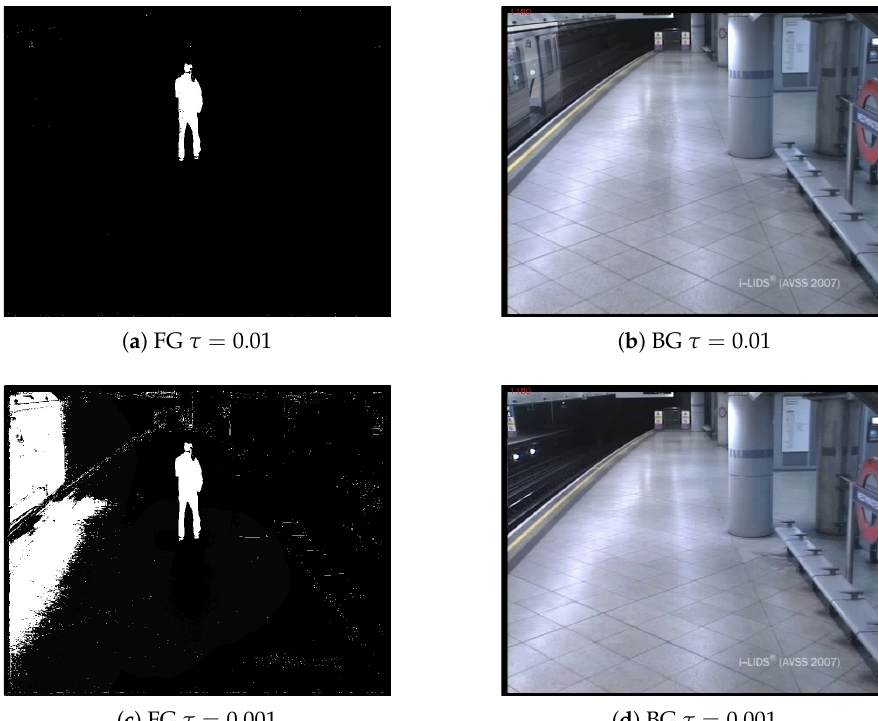
Figure 3. Examples of different adaptation rates for background subtraction based on the Mixture of Gaussians approach [45] for Frame 1180 of the sequence AVSS_AB_2007 (http://www.eecs.qmul.ac. uk/~andrea/avss2007_d.html). Subfigures ( a , c ) show Foreground (FG) masks with different parameter τ , which controls the update rate of the Background (BG) models, that are depicted in subfigures ( b , d